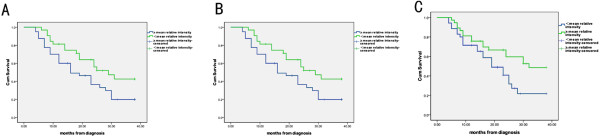
Correlation between relative intensity of three peptides and overall survival (OS). (A) Patients who had higher relative intensity of ubiquitin-like modifier activating enzyme 1(≥mean relative intensity) had a significantly inferior outcome. (B) The OS rate was higher in patients with increased relative intensity (≥mean relative intensity) of isoform 1 of fibrinogen alpha chain precursor. (C) Lower relative intensity of platelet factor 4(<mean relative intensity) associated with an unfavorable OS.